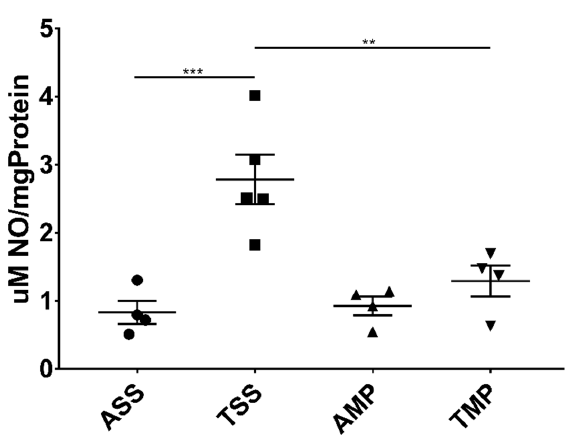
Figure 3. Central nitric oxide levels ( µ M/mg protein) in soluble extract from brain of mice repeatedly exposed to toluene and measured by Griess reaction. All results are shown as the mean ± standard error of groups values. ** p < 0.01, *** p < 0.001. ANOVA followed by Tukey’s test were performed. Air + saline solution (ASS); toluene + saline solution (TSS); air + methylprednisolone (AMP); toluene + methylprednisolone (TMP).